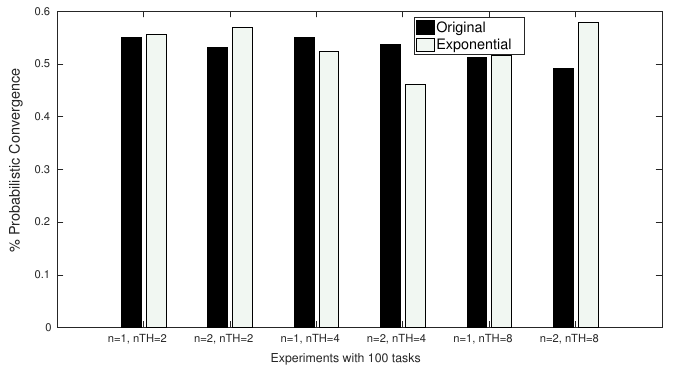
Figure 3. Percentage of experiments that converge with 100 tasks using probabilistic Markov